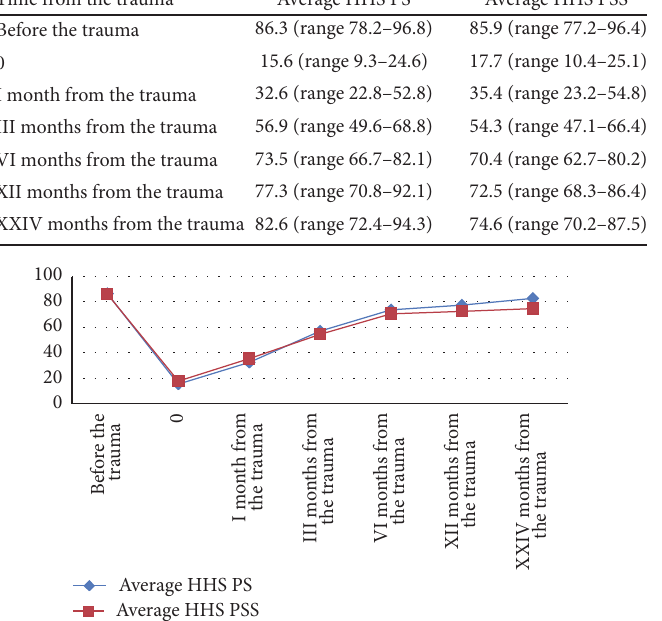
Figure 2: Trend hip function and quality of life related to it for 2-year follow-up measured by Harris Hip Score (HHS). At six months there was a statistically significant difference ( 𝑝 < 0.05 ) in favor of the PS group.